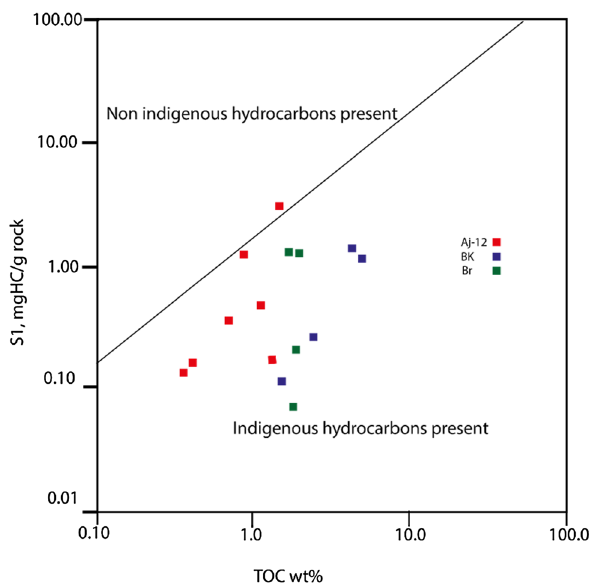
Fig. 14 Plot of S1 vs. TOC% of the rocks of Chia Gara Formation.